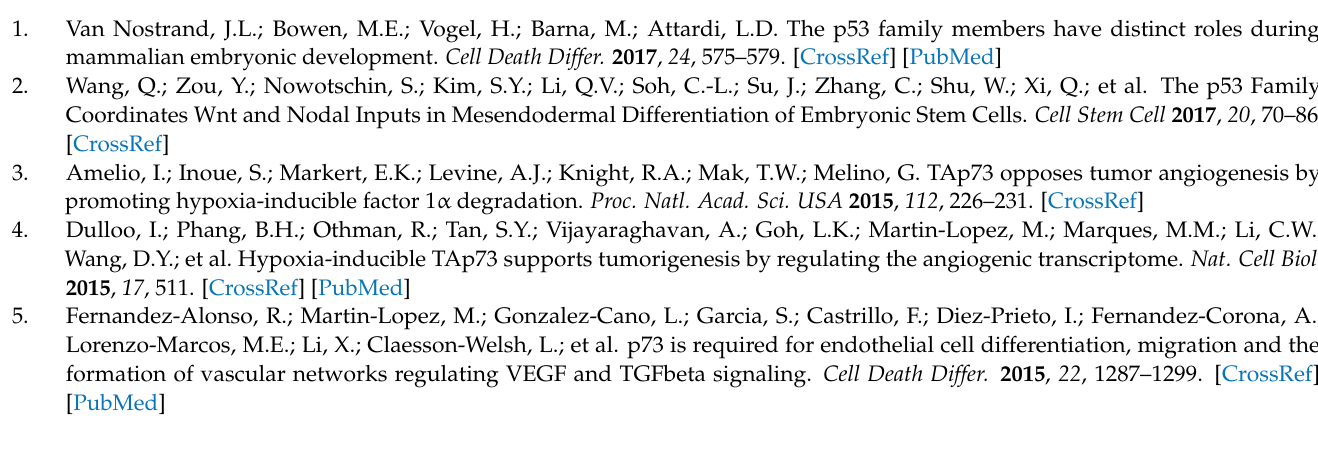
Figure S3: mESC characteristic colony phenotype is lost in E14-TAp73KO cells, Figure S4: p73 deletion affects colony thickness, Figure S5: Expression of pluripotency markers, Figure S6: Neural premature differentiation is present in all E14-DNp73KO clones, Table S1: Genome-wide transcriptome profiling of the three genotypes under self-renewal or differentiation culture conditions, Table S2: List of differentially expressed genes which are direct or indirect transcriptional control of either TA- or DN-p73, Table S3: Comparison of differentially expressed genes in E14-TA- and E14-DNp73 cells with p73 transcriptional targets analyzed in Wang et al.